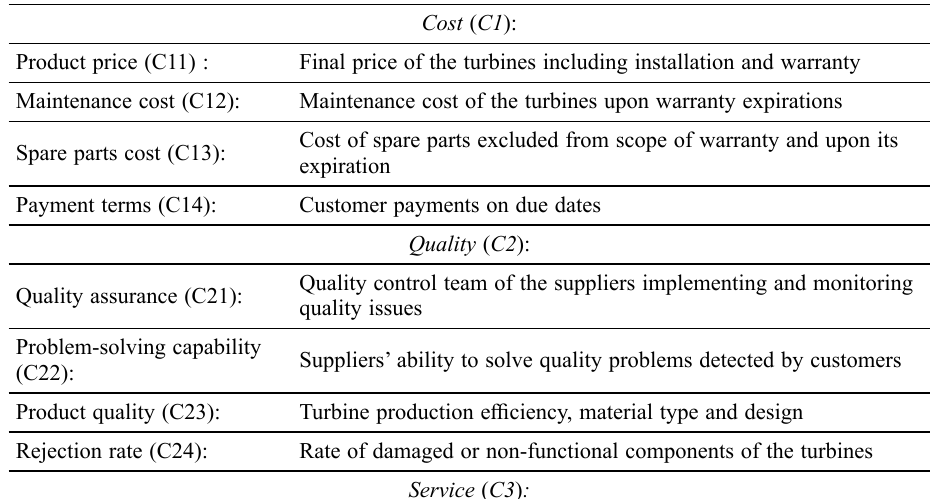
Table 1. Descriptions of criteria and